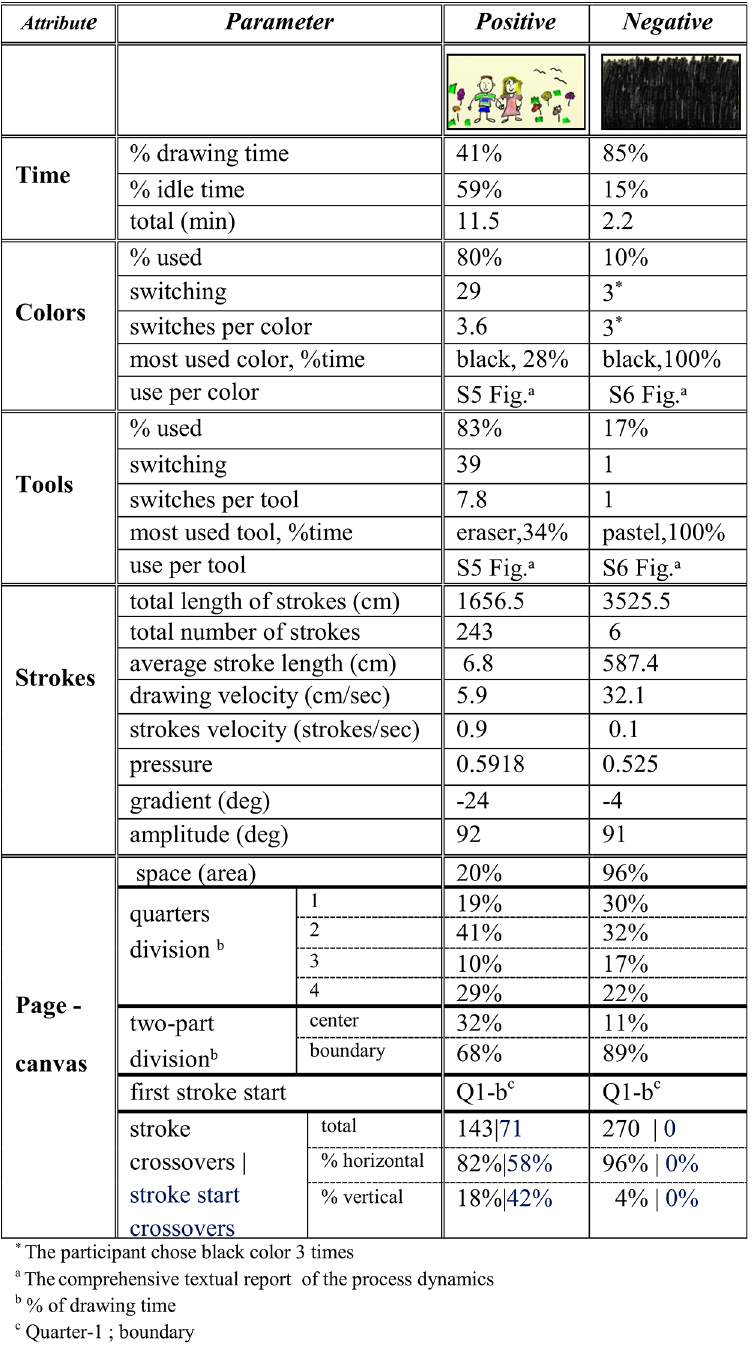
Fig 11. An example of parameters/metrics comparison of an individual's artworks construction processes. The processes compared are of the creation of a positive feeling image and that of a negative